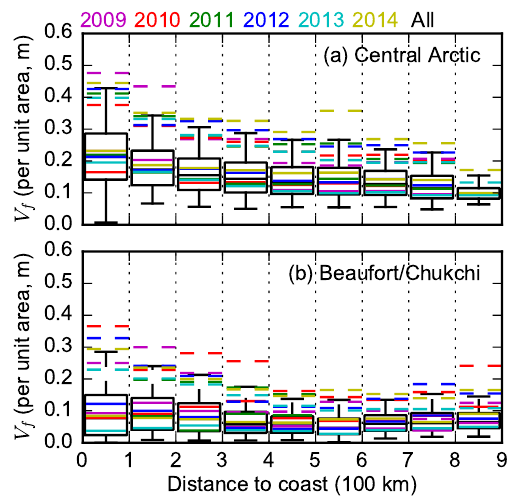
Figure 11. As in Fig. 10 but for the surface feature volume (per unit area), V f .